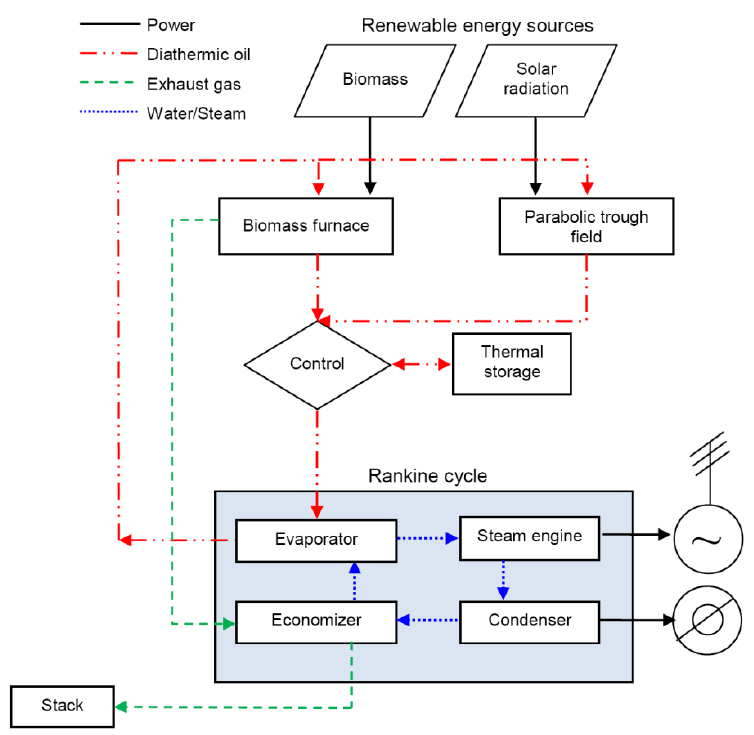
Figure 1. Power plant diagram.